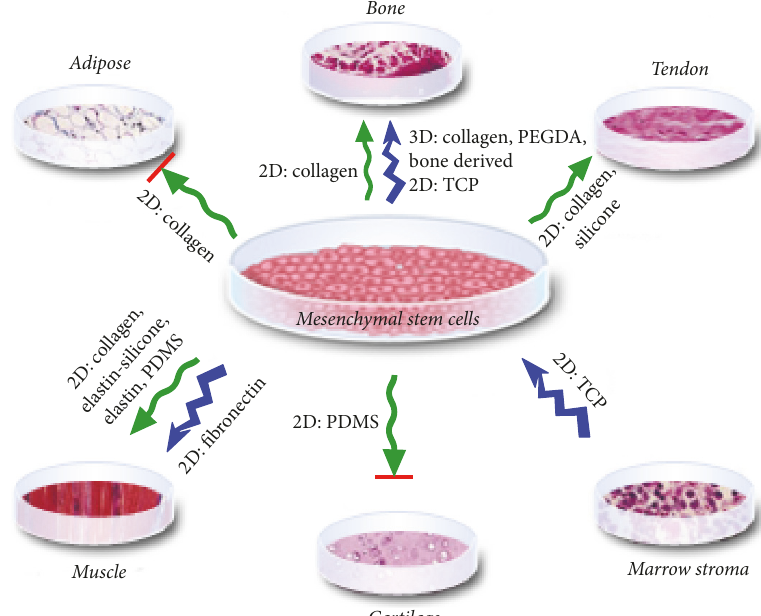
Figure 1: Diagram representing the effects of vibration (blue jagged arrow) and cyclic tensile strain (green squiggly arrow) on MSCs. The arrows depict the loading type. The italics detail the in vitro culture conditions in which the differentiation into the indicated lineage was observed. Red lines indicate inhibition of the downstream lineage. Tissue images from Tuan et al. [4], CC BY